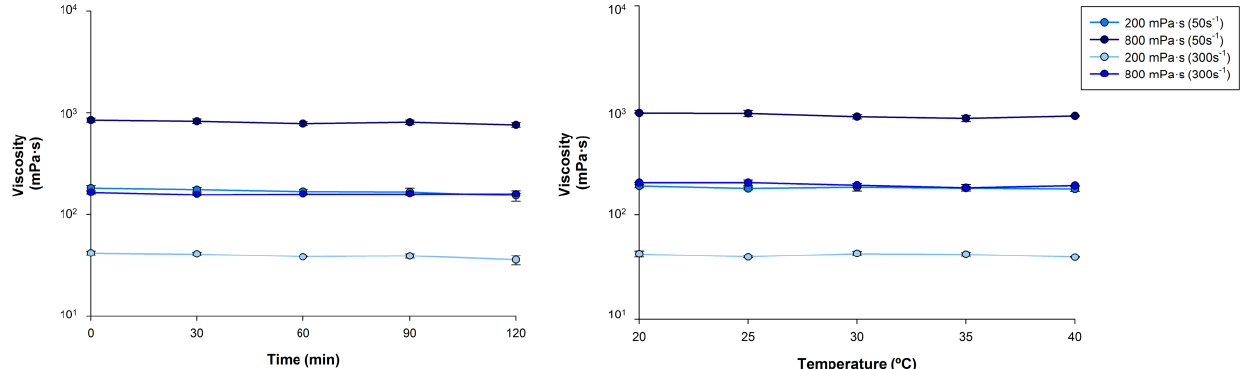
Figure 4. Viscosity values (mean ± SD at 50 and 300 s −1 ) by increasing time from 0 to 120 min ( right ) and temperature from 20 to 40 °C ( left ) for 200 and 800 mPa·s levels for daily condition doses. 3.3. Effect of the X-ray Contrast Omnipaque on the Rheological Properties Dose adaptation. Solutions with X-ray contrast in water (1:1 vol / vol ) were adapted to the volume normally used for VFS in Lab3 (50 mL) to achieve the target ShV. The doses